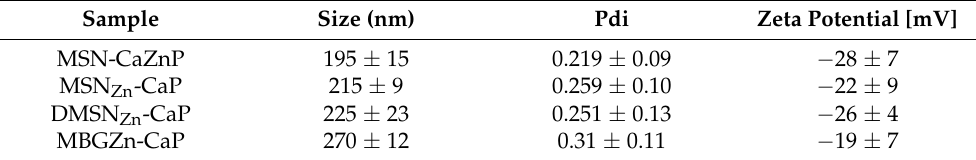
Figure 1. TEM images showing mesoporous structure and nanoparticle size of ( a ) MSN-CaZnP, ( b ) MSN Zn -CaP, ( c ) DMSN Zn -CaP and ( d ) MBGZn-CaP. Scale bar is 50 nm. Table 1. Hydrodynamic size, Pdi and surface zeta potential of MSN-CaZnP, MSN Zn -CaP, DMSN Zn - CaP and MBGZn-CaP measured by dynamic light scatting. All nanoparticles were measured in distilled water.